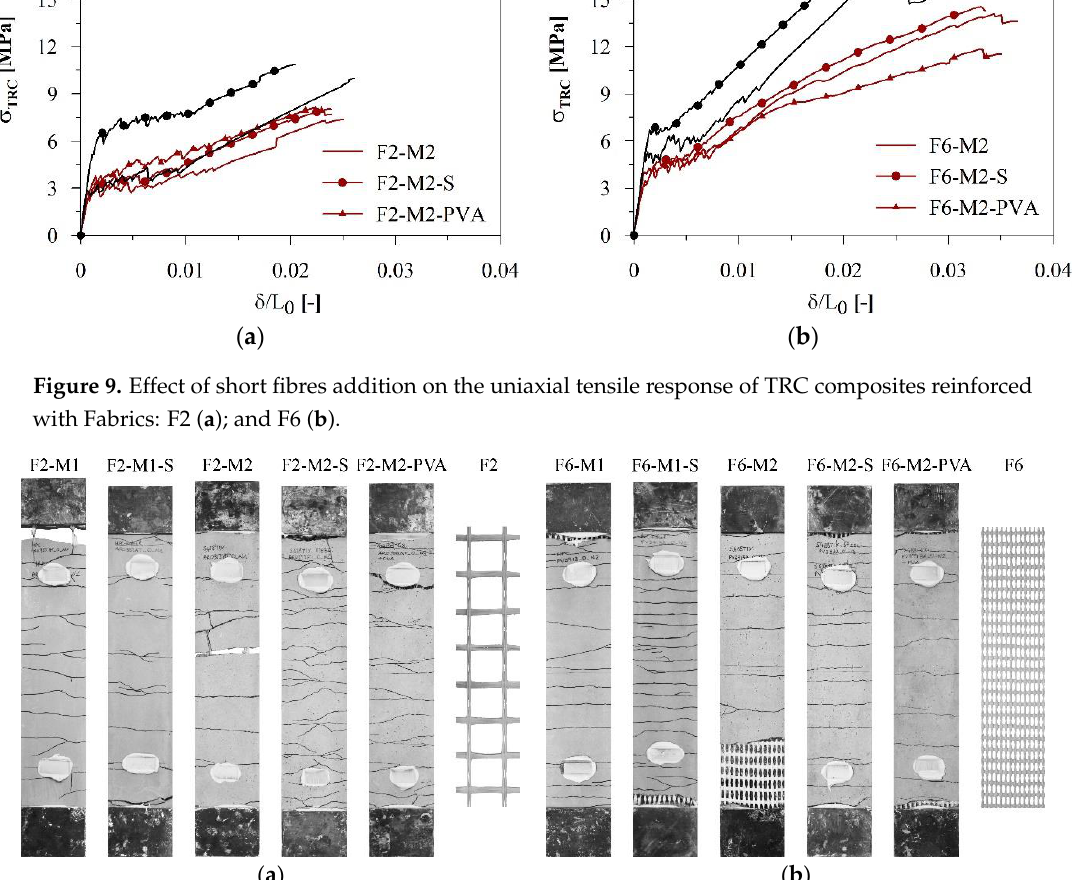
Figure 10. Cracking patterns with and without short fibres for TRC composites reinforced with Fabrics: F2 ( a ); and F6 ( b ).